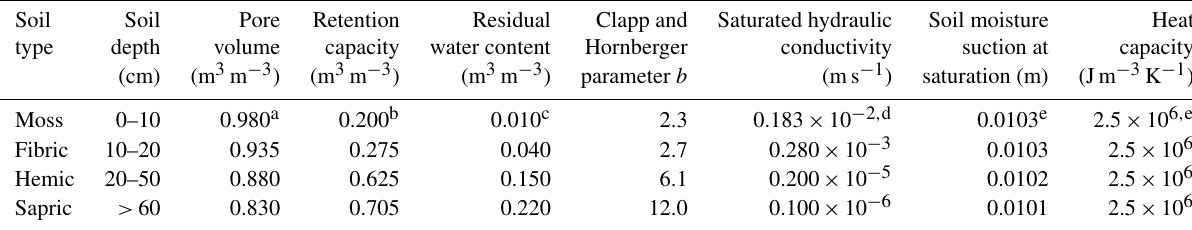
Table 1. Physical properties of organic soil types. Soil Soil Pore Retention Residual Clapp and Saturated hydraulic Soil moisture Heat type depth volume capacity water content Hornberger conductivity suction at capacity (cm) (m 3 m − 3 ) (m 3 m − 3 ) parameter b Moss 0–10 Hemic 20–50 0.880 0.625 Sapric >